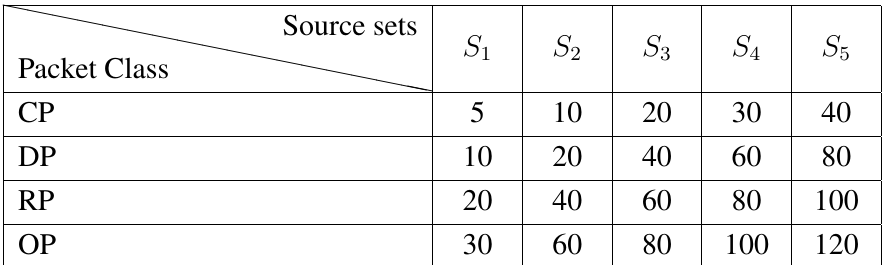
Table 3. Five different sets of source traffic